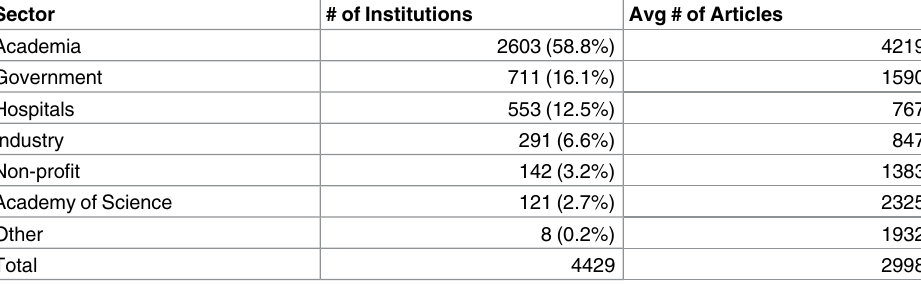
Table 2. Institutions by sector